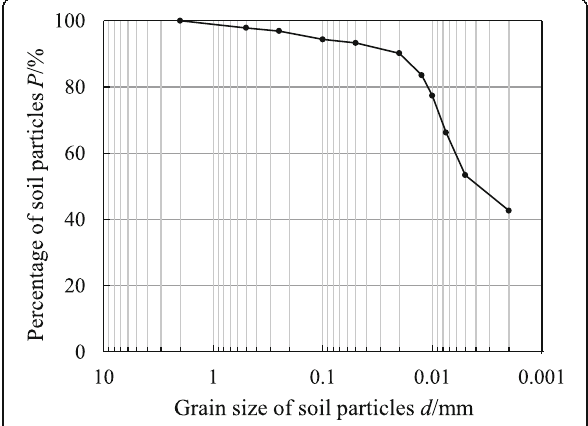
Fig. 4 Distributions of the grain size of the yellow-brown earth in karst